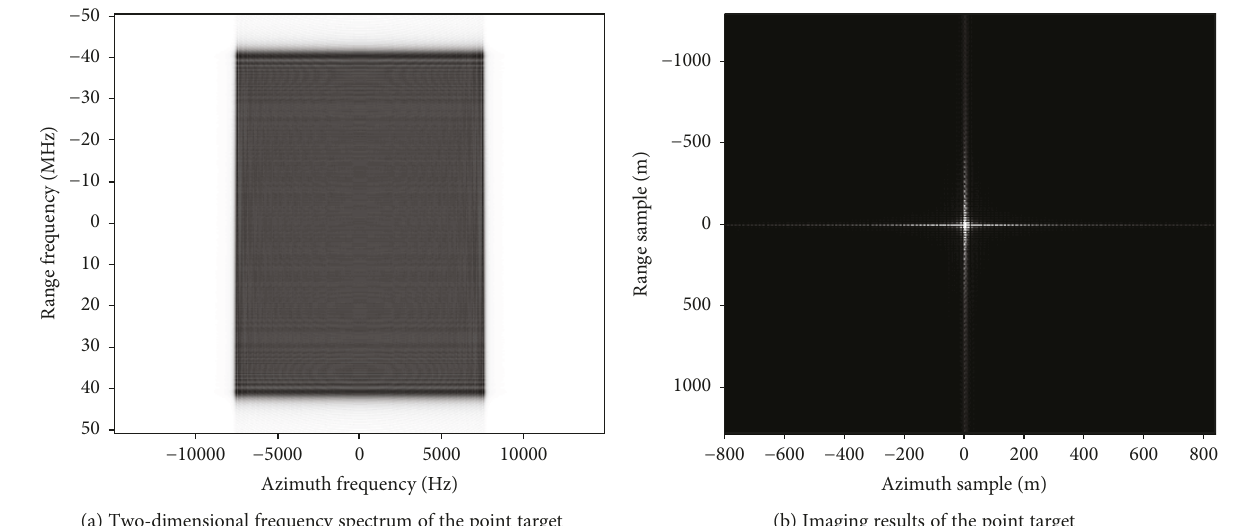
Figure 5: Imaging result by the proposed imaging